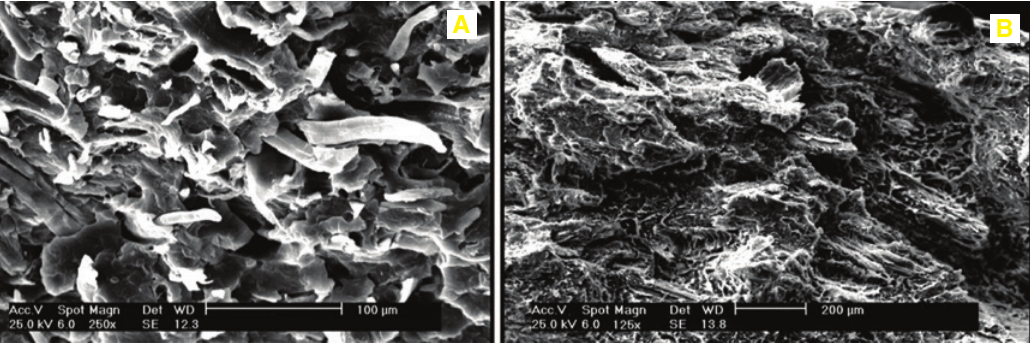
Figure 5: SEM micrograph of the fracture surfaces of the composite samples used for tensile strength measurements. (A) Non-delignified sample showing fibers pulled out of the matrix. (B) Sample with 2.8% lignin showing the fracture without any fiber pulled